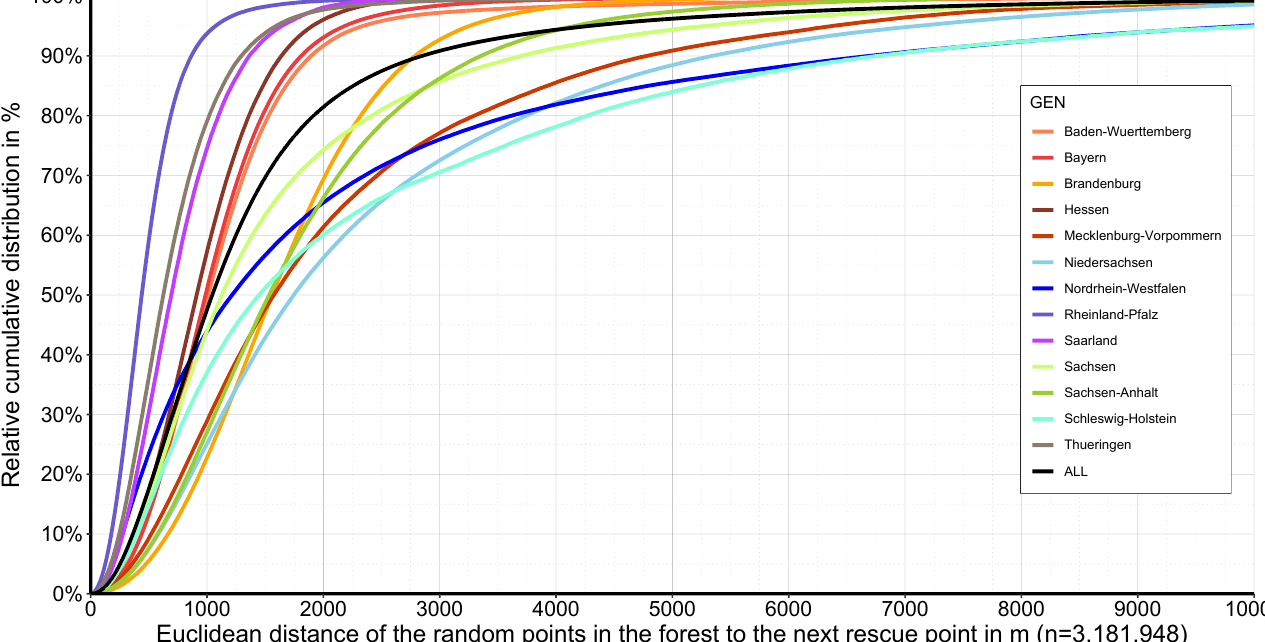
Figure 6. Relative cumulative distribution of the Euclidean distance from random points in the forest to the nearest rescue point for the different federal states and the federal level. The steeper the curves, the shorter the potential distance to the nearest rescue meeting point. If the curve is flat, it can be assumed that the density of rescue points is